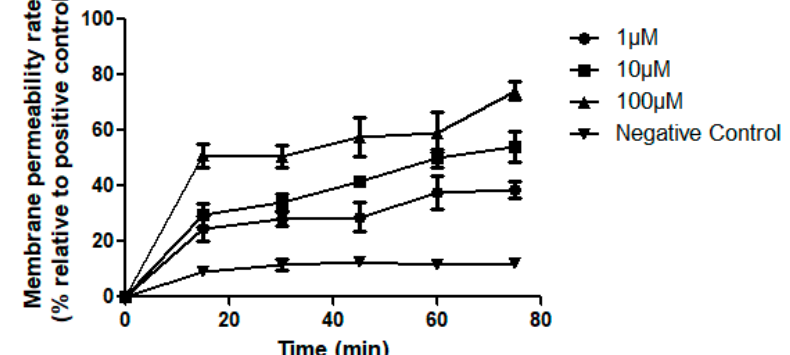
Figure 12. Cell membrane permeability effects of Dermaseptin-PH on MCF-7 cell by using SYTOX Green (1 µ M) (Life technologies) at peptide concentrations from 1 to 100 µ M. Positive control was obtained following incubation with 0.5% Triton X-100. Negative control was obtained following incubation with relevant serum-free culture medium. Data represent means ± SEM of 5 replicates.